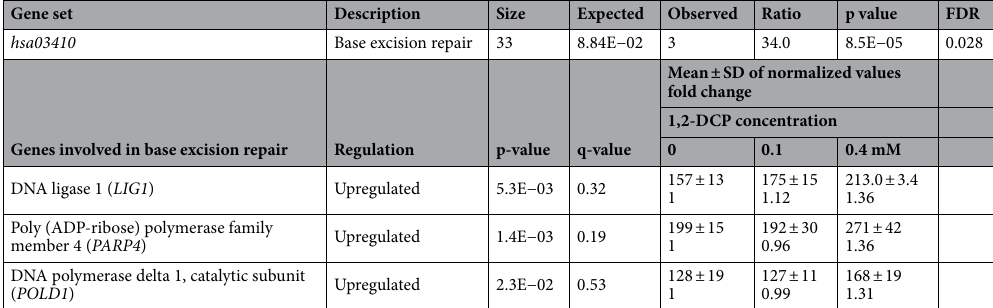
Table 1. KEGG pathway overrepresentation analysis of ME9 module and list of involved genes in MMNK-1 cholangiocytes co-cultured with THP-1 macrophages. The table shows KEGG pathway overrepresentation analysis of ME9 module and involved genes from the transcriptomic profiles of MMNK-1 cholangiocytes co-cultured with THP-1 macrophages when exposed to 1,2-DCP at 0, 0.1 or 0.4 mM for 24 h. The analysis was peformed by WebGestalt with False Discovery Rate (FDR) cut-off value of 0.05. Data of normalized values for gene expression are mean ± SD, n = 3. Fold change represents the value relative to the average of the control group (0mM). All p-values for gene expression were adjusted using Benjamini-Hochberg method and expressed as q-values.